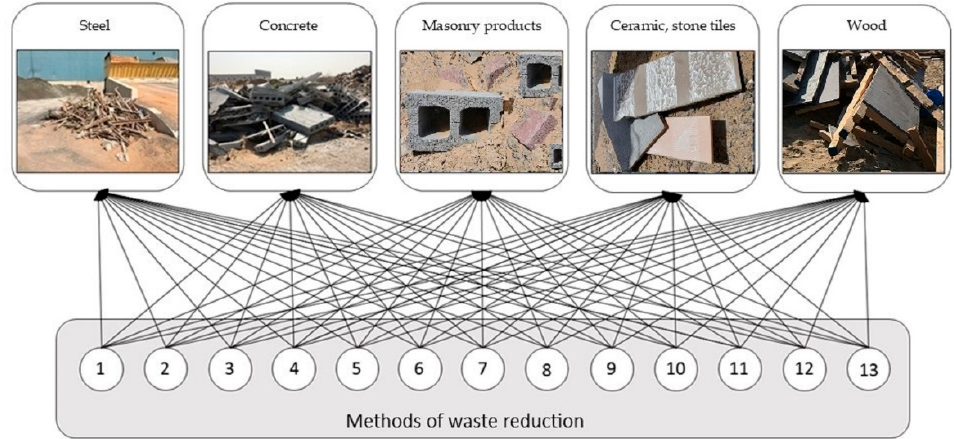
Figure 4. Schematic diagram of linking construction waste reduction methods with the studied groups of building products [graphic and photos are own materials].